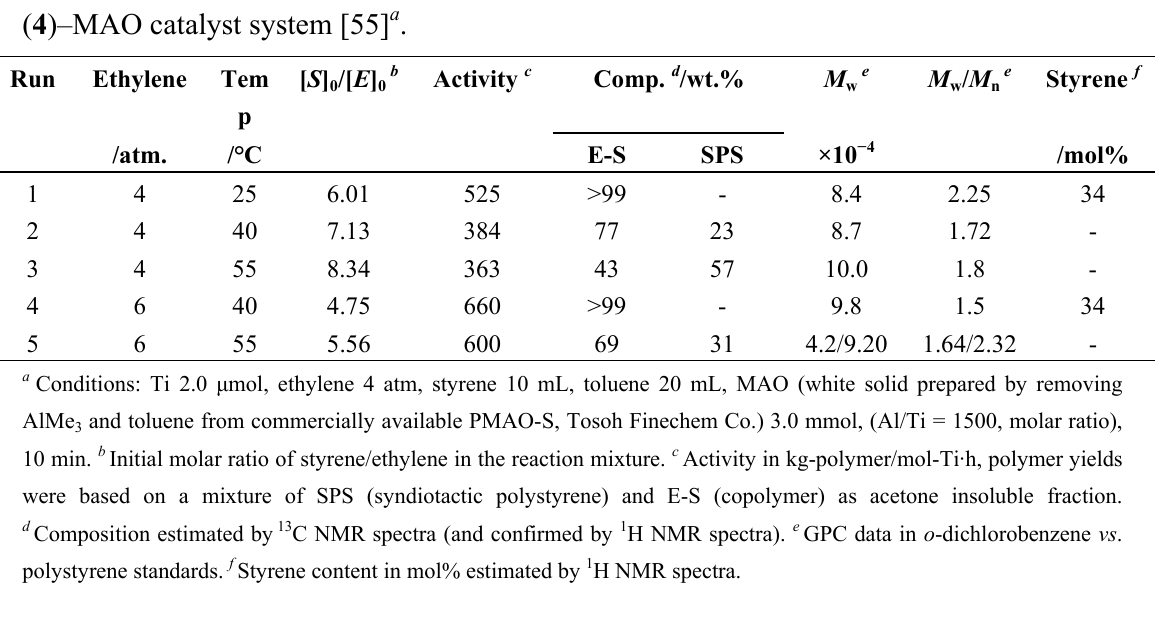
( O -2,6- i Pr C H ) 2 2 6 3